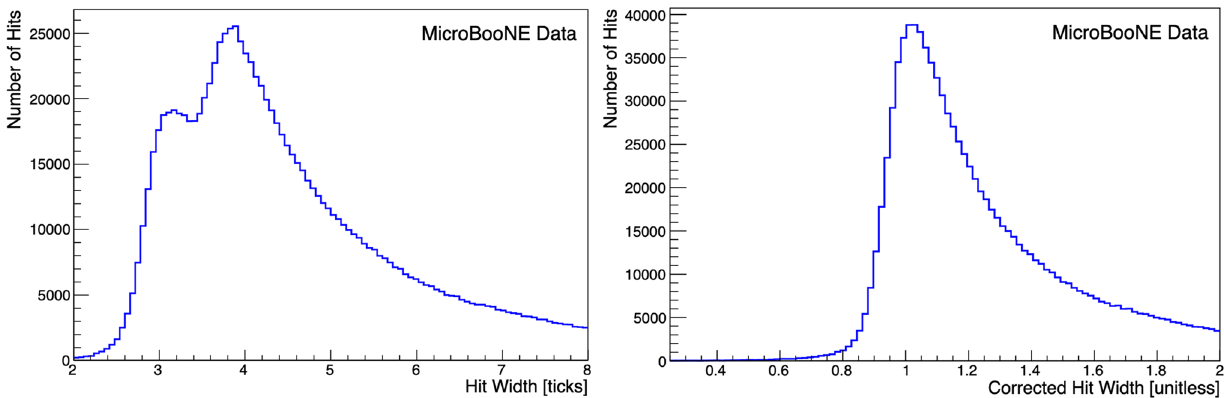
Fig. 6 Distribution of hit widths on the collection plane for − 10 < y < 0cm in the cosmic data. On the left, this distribution before any correction for the hit width dependence on x . A time tick translates to 0.5 µ s [1]. The “double-peak” structure is evident, where the low-width peak comes from ACPT trajectory points near the anode and the high-